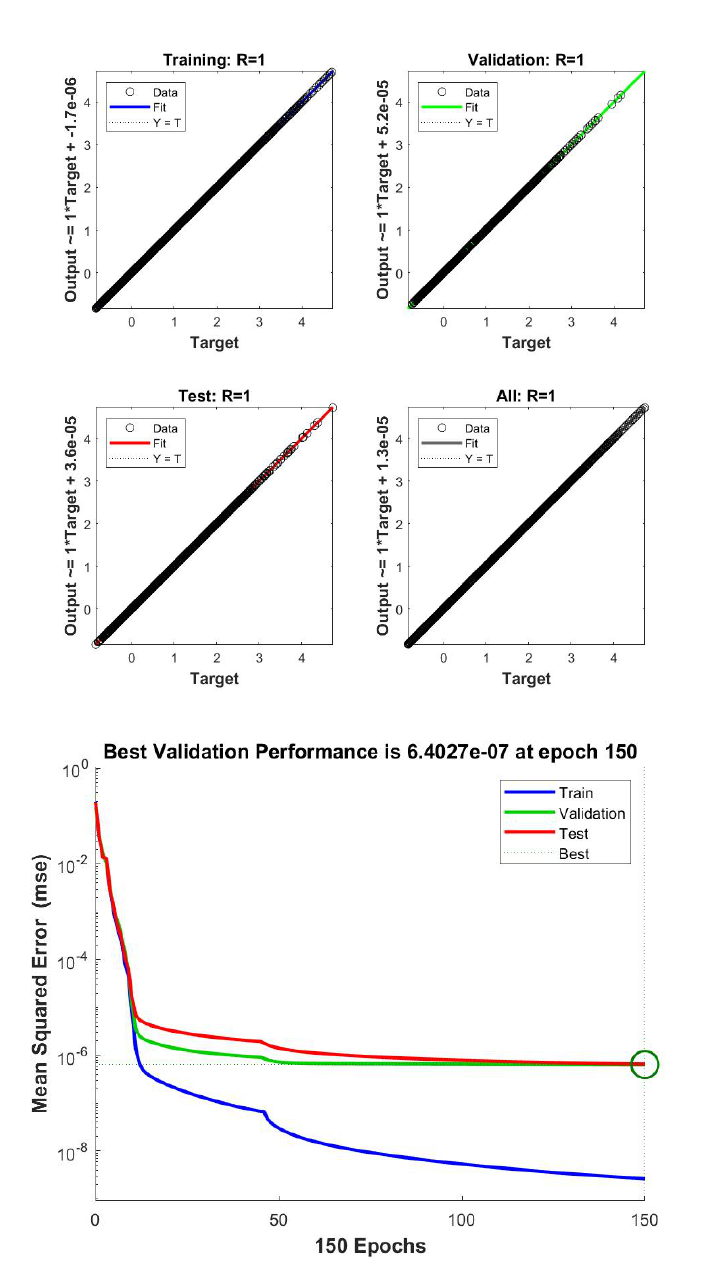
Figure 36. Correlation coefficient R between target data and output data for training, validation and test and mean squared error for the best validation